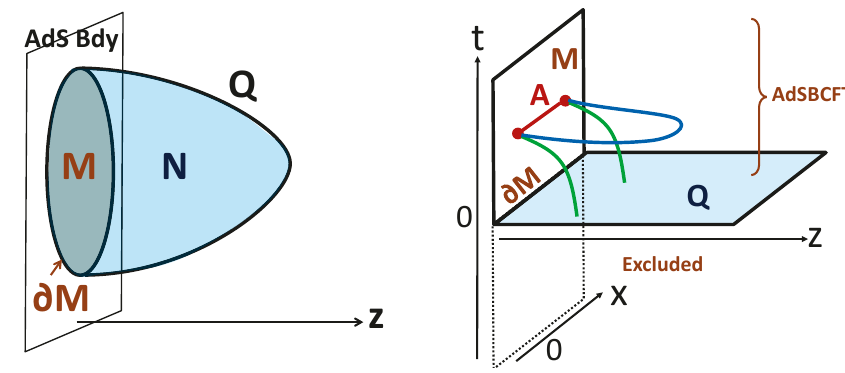
Figure 2 . A sketch of AdS/BCFT analysis for AdS 3 . A holographic CFT on M (with the boundary @M ) is dual to gravity on N . The boundary of N consists of the surface Q and M . The right picture shows the calculation of holographic entanglement entropy. The blue curve gives the connected geodesic contribution and the green ones are the disconnected geodesics which end on the boundary surface Q . The correct holographic entanglement entropy is given by the one with a smaller